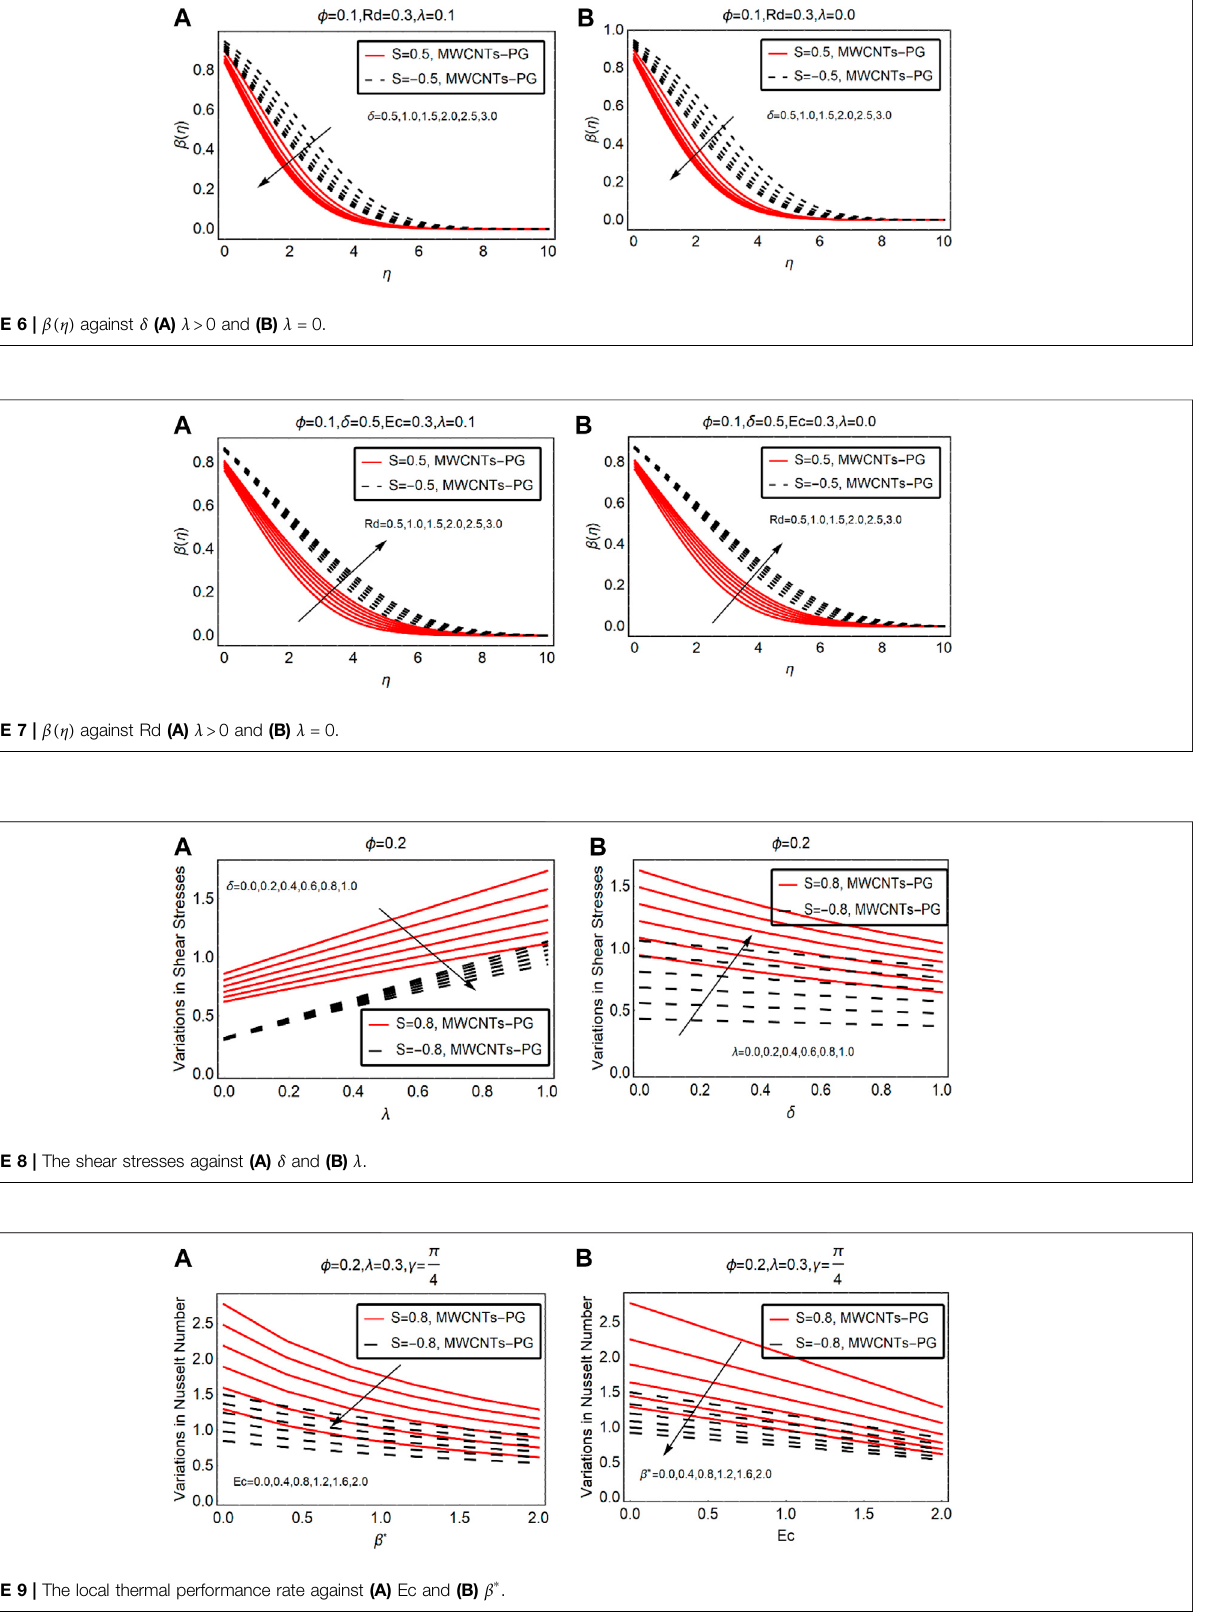
Frontiers in Chemistry |